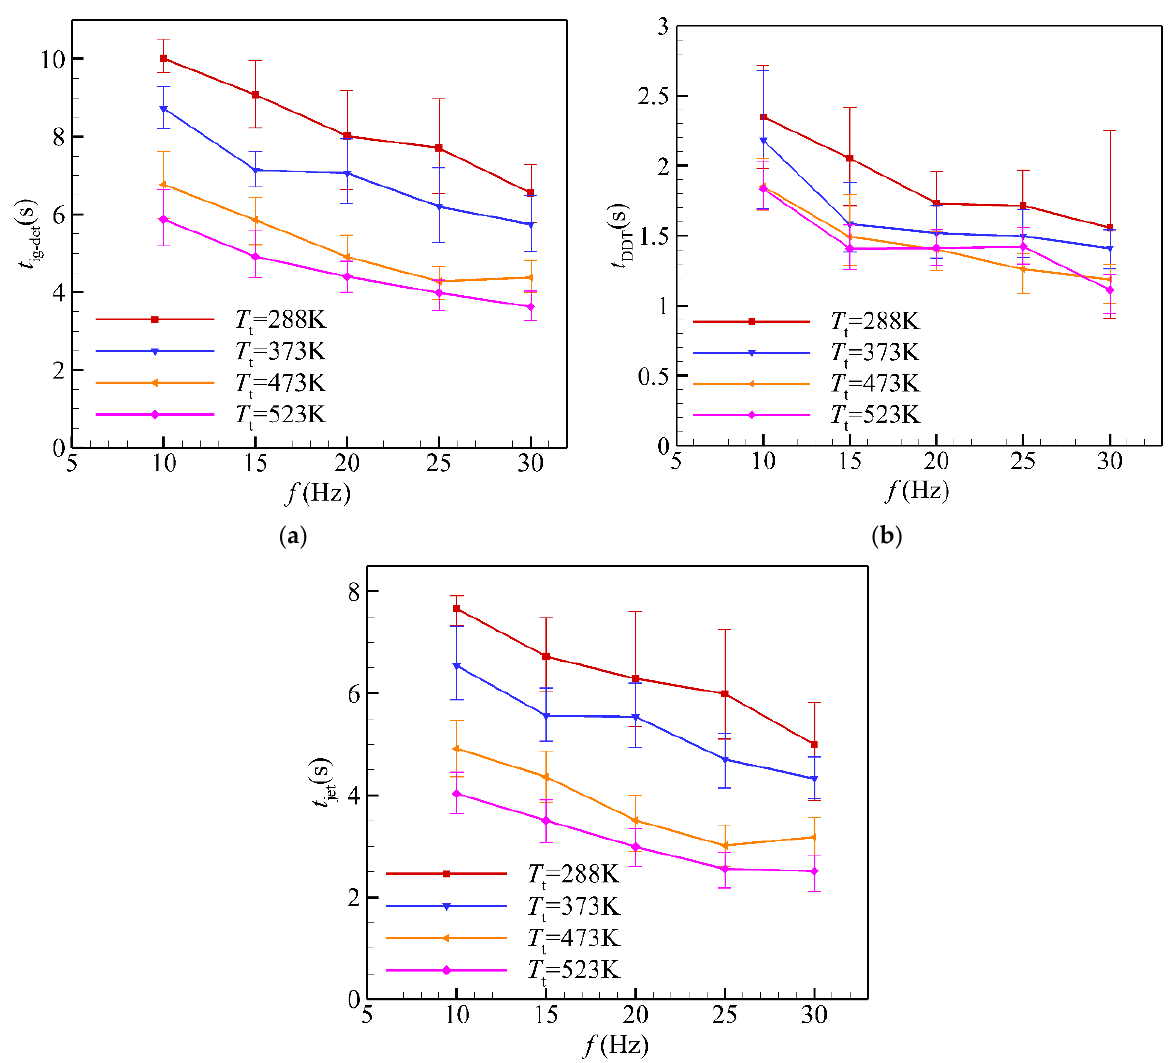
Figure 8. Detonation initiation time, jet ignition time and DDT time at different working conditions. ( a ) The detonation initiation time of PDC. ( b ) The DDT time of PDC. ( c ) The jet ignition time of